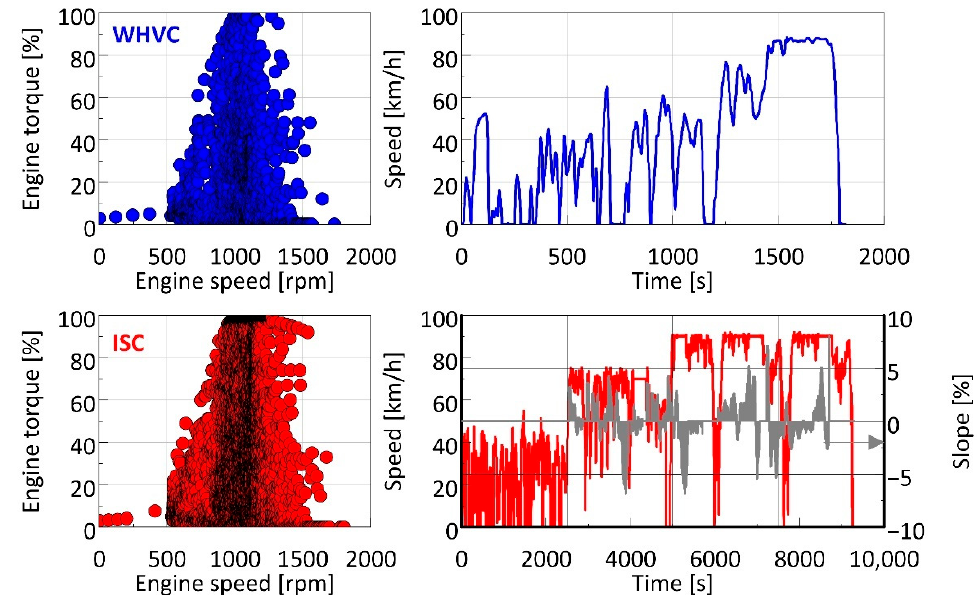
Figure 2. Operating engine maps and speed profiles of the WHVC (top panels) and ISC (bottom panels) test cycles. The slope applied over the ISC is also shown on a separate axis. ISC = In-Service Conformity Cycle; WHVC = Worldwide Harmonized Vehicle